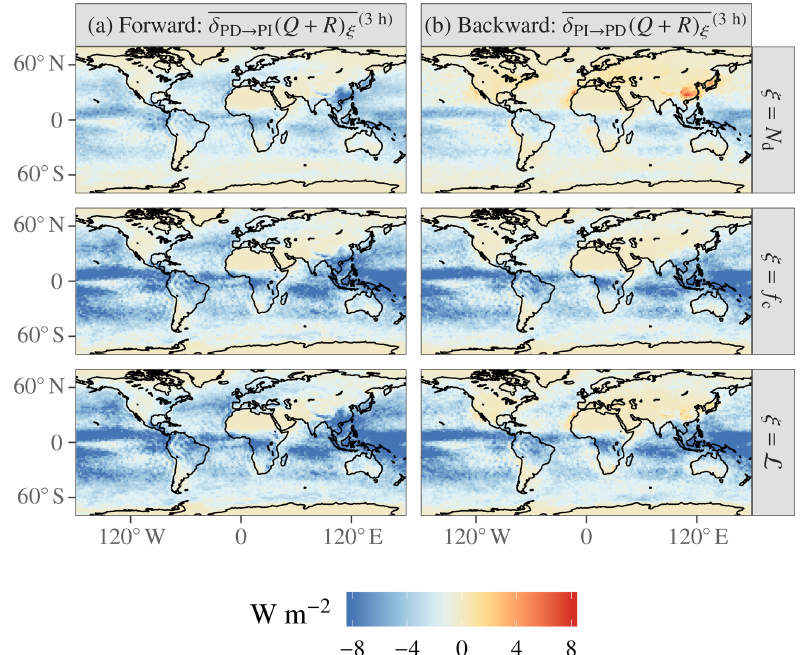
Figure A1. Forward (a) and backward (b) PRP estimates of the ERF aci components. Note the significantly wider color scale than in Fig. 1.